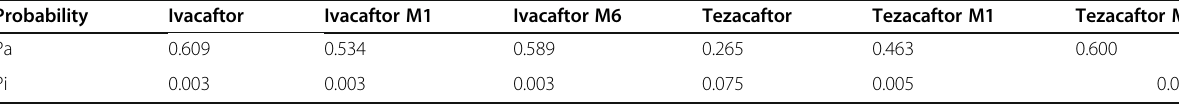
Table 21 Biological spectrum of Ivaacaftor, Tezacaftor, and its metabolites